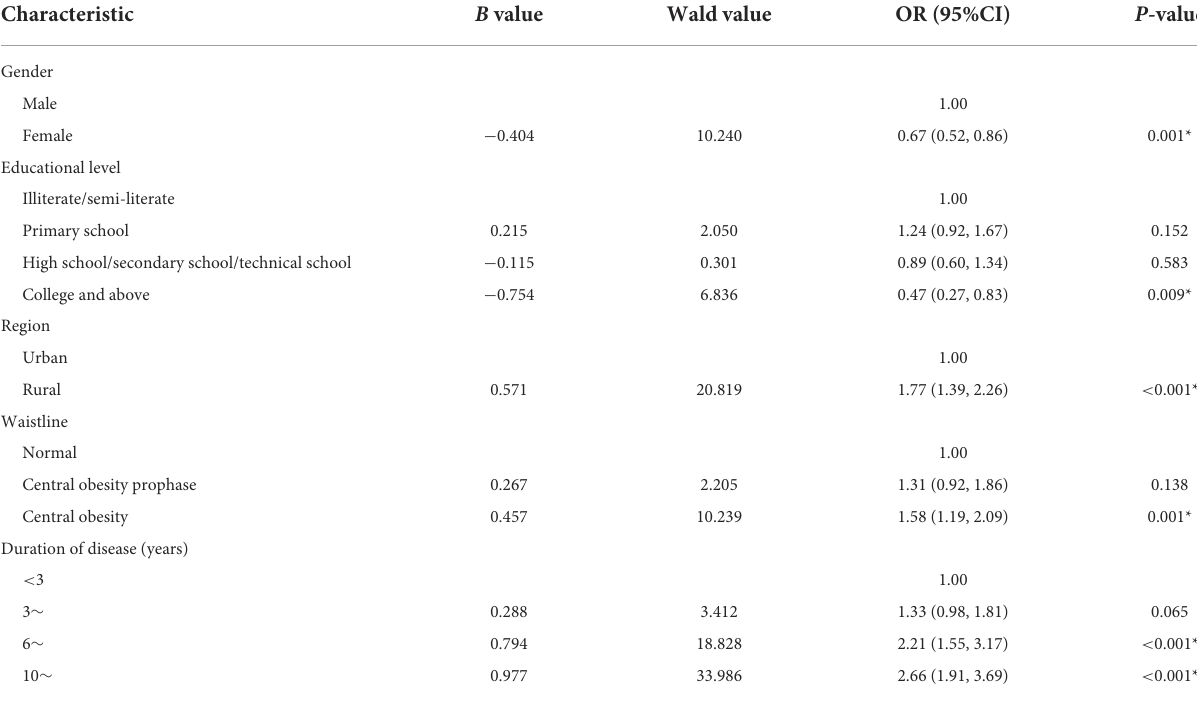
TABLE 4 Multivariate unconditional logistic regression analysis of glycemic control in patients with T2D.